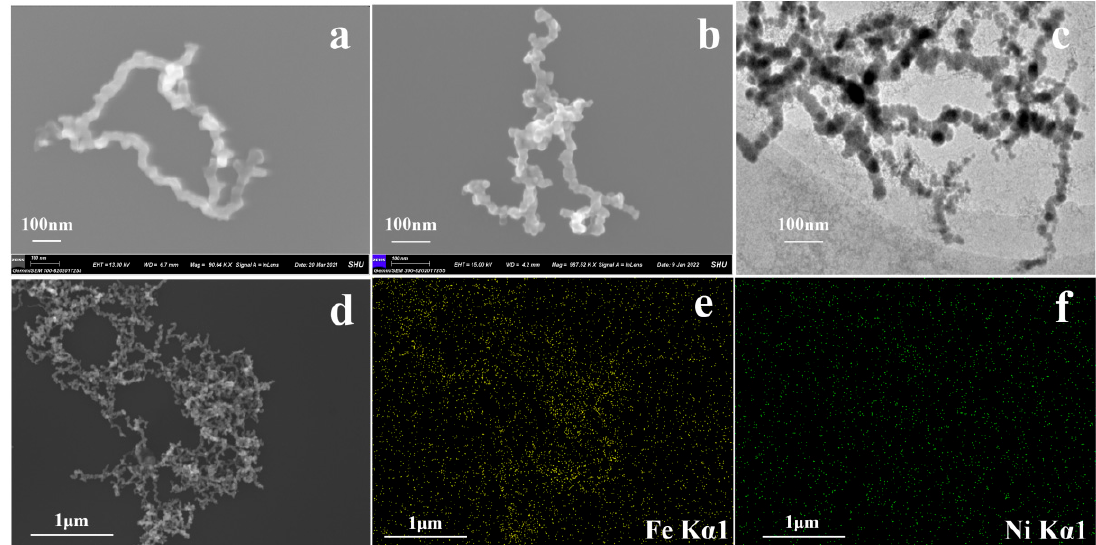
Figure 2. ( a ) SEM images of nZVI; ( b ) 5% Ni-nZVI; ( c ) TEM images of 5% Ni-nZVI; and ( d – f ) SEM-EDS of 5% Ni-nZVI.